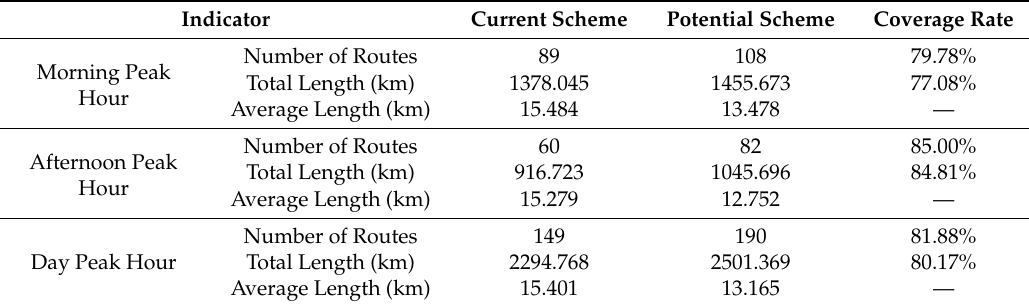
Table 2. Beijing CB network contrast.